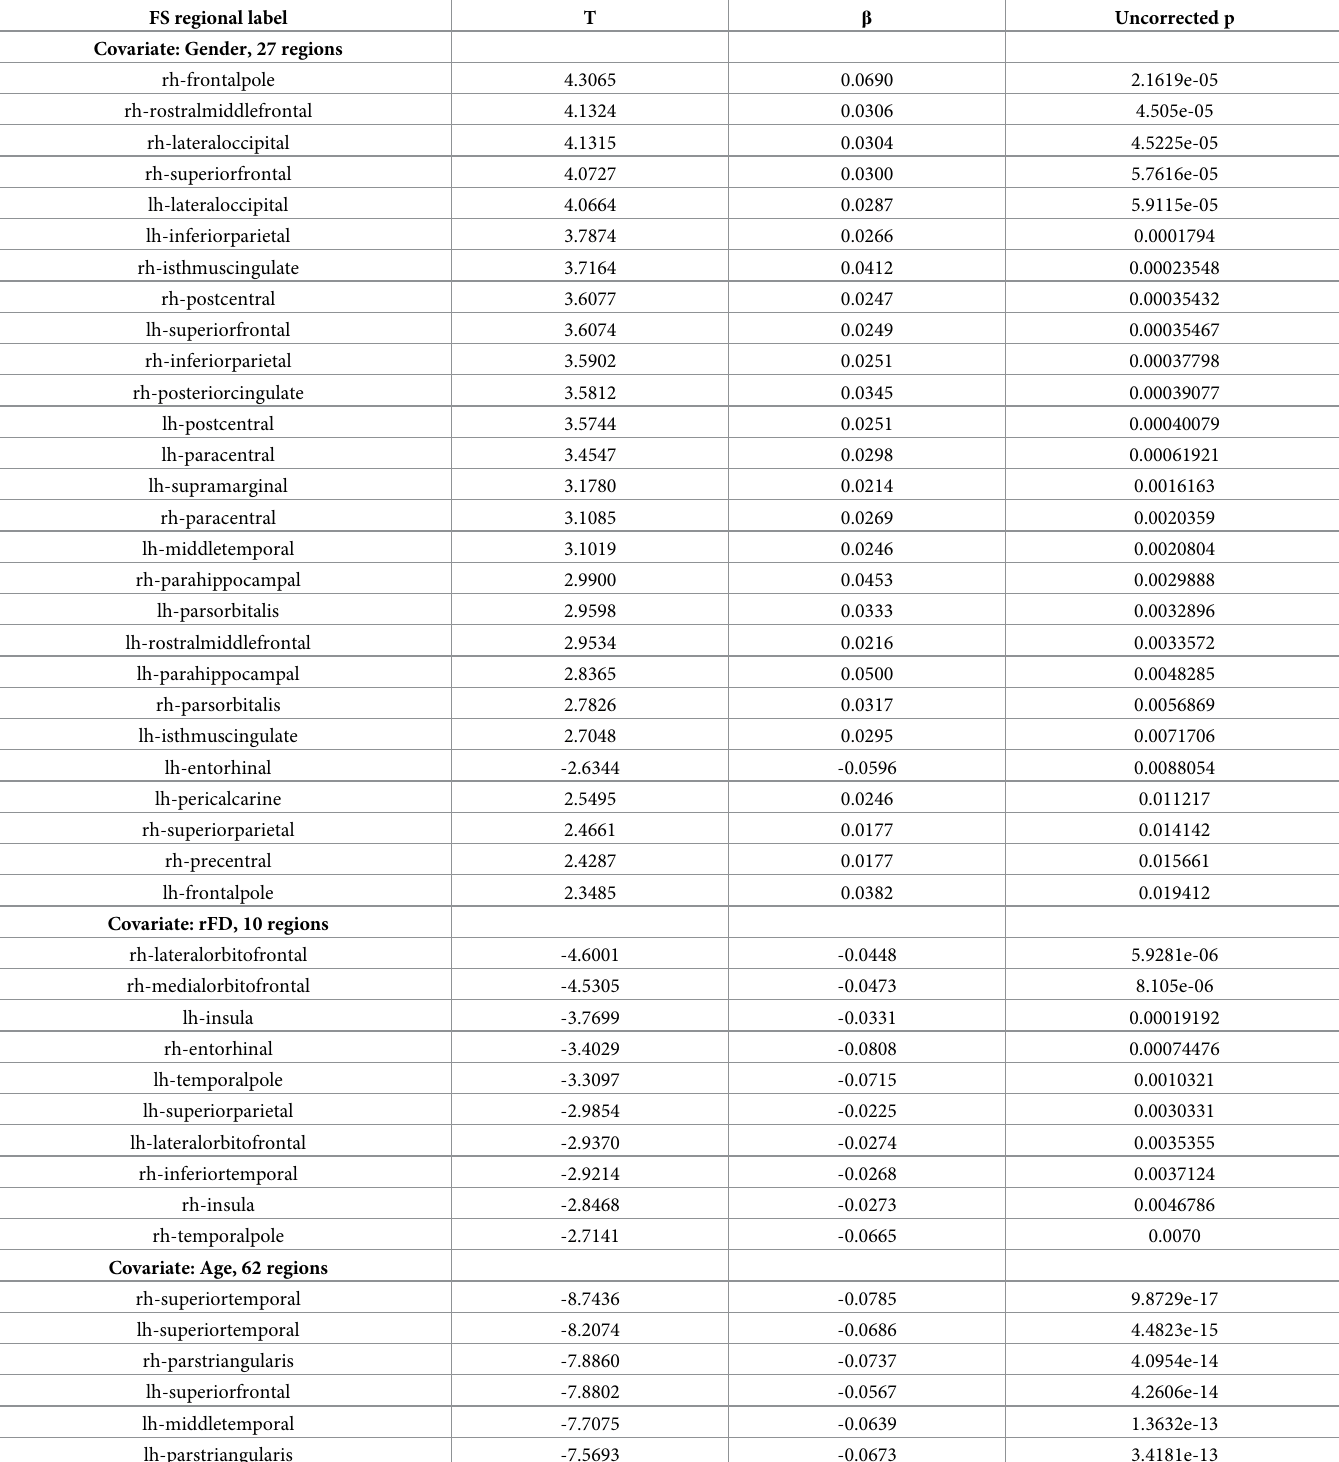
Table 2. FDR-corrected associations (Q < 0.05) between regional thickness and gender, rFD and age, from multiple linear regressions with education, total cogni- tion, gender, rFD, and age as simultaneous, z-standardized, covariates. No associations at Q < 0.05 were found for education and total cognition. FS regional